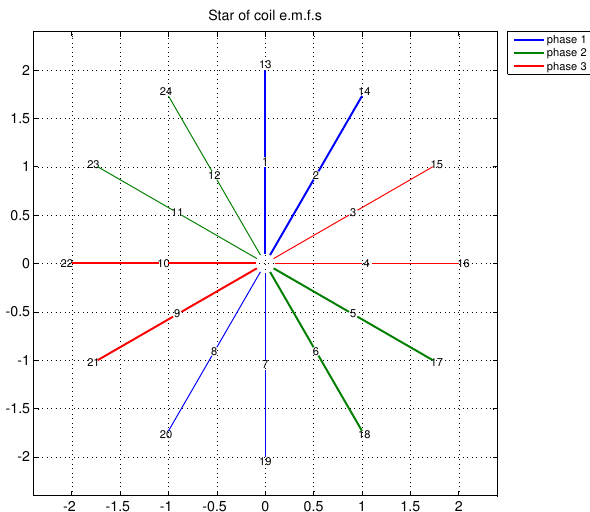
Figure 1. Plot of the EMF star for a symmetrical winding with N = 24, m = 3 and p =